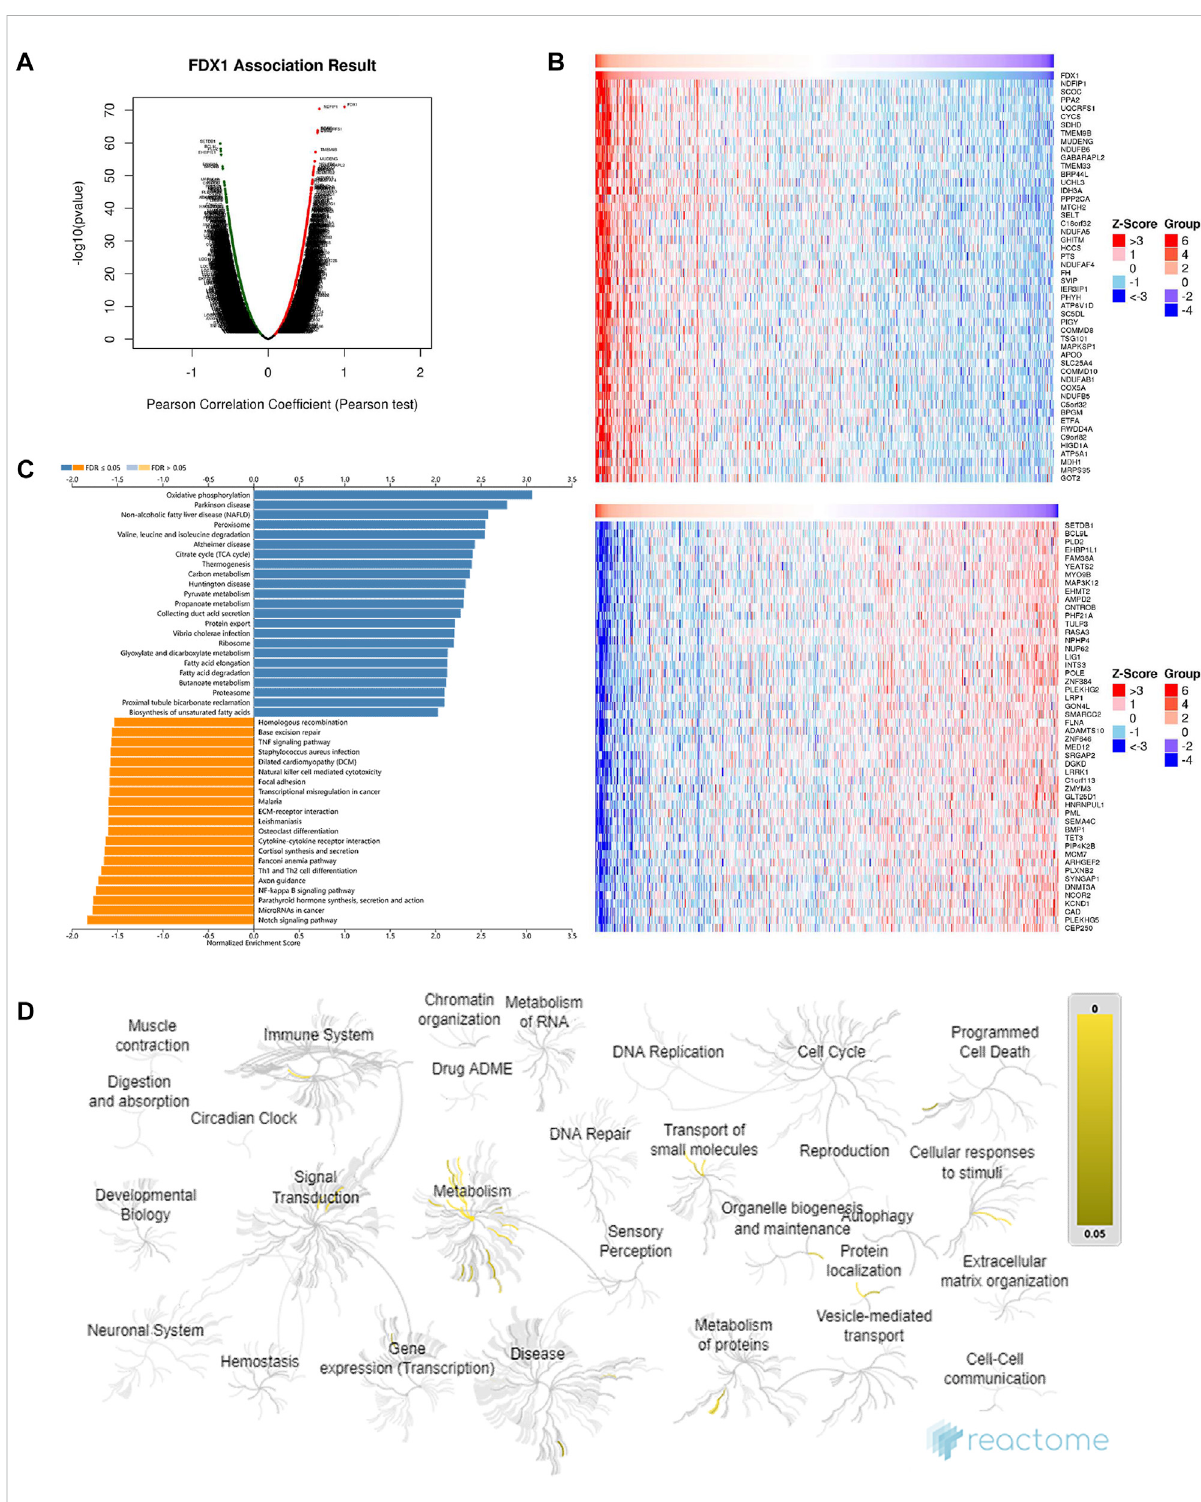
FIGURE 6 Functional enrichment analysis and co-expression pro fi le highly associated with FDX1 expression in ccRCC. (A) Volcano plot of differentially expressed genes associated with FDX1 based on Pearson ’ s correlation coef fi cient analysis. Genes with a green dot were downregulated, whereas geneswithareddotwereupregulated. (B) Thetop50co-expressedgenes ’ heatmapsshowapositive(upperheatmap)andnegative(lowerheatmap) correlation with FDX1. (C) A bar diagram of the upregulated (blue bar) and downregulated (orange bar) signalling pathways revealed by KEGG analysis. (D) Functional enrichment of the top 100 genes positively correlated with FDX1 expression in the Reactome enrichment pathways with yellow gradient representing statistical signi fi cance ( p